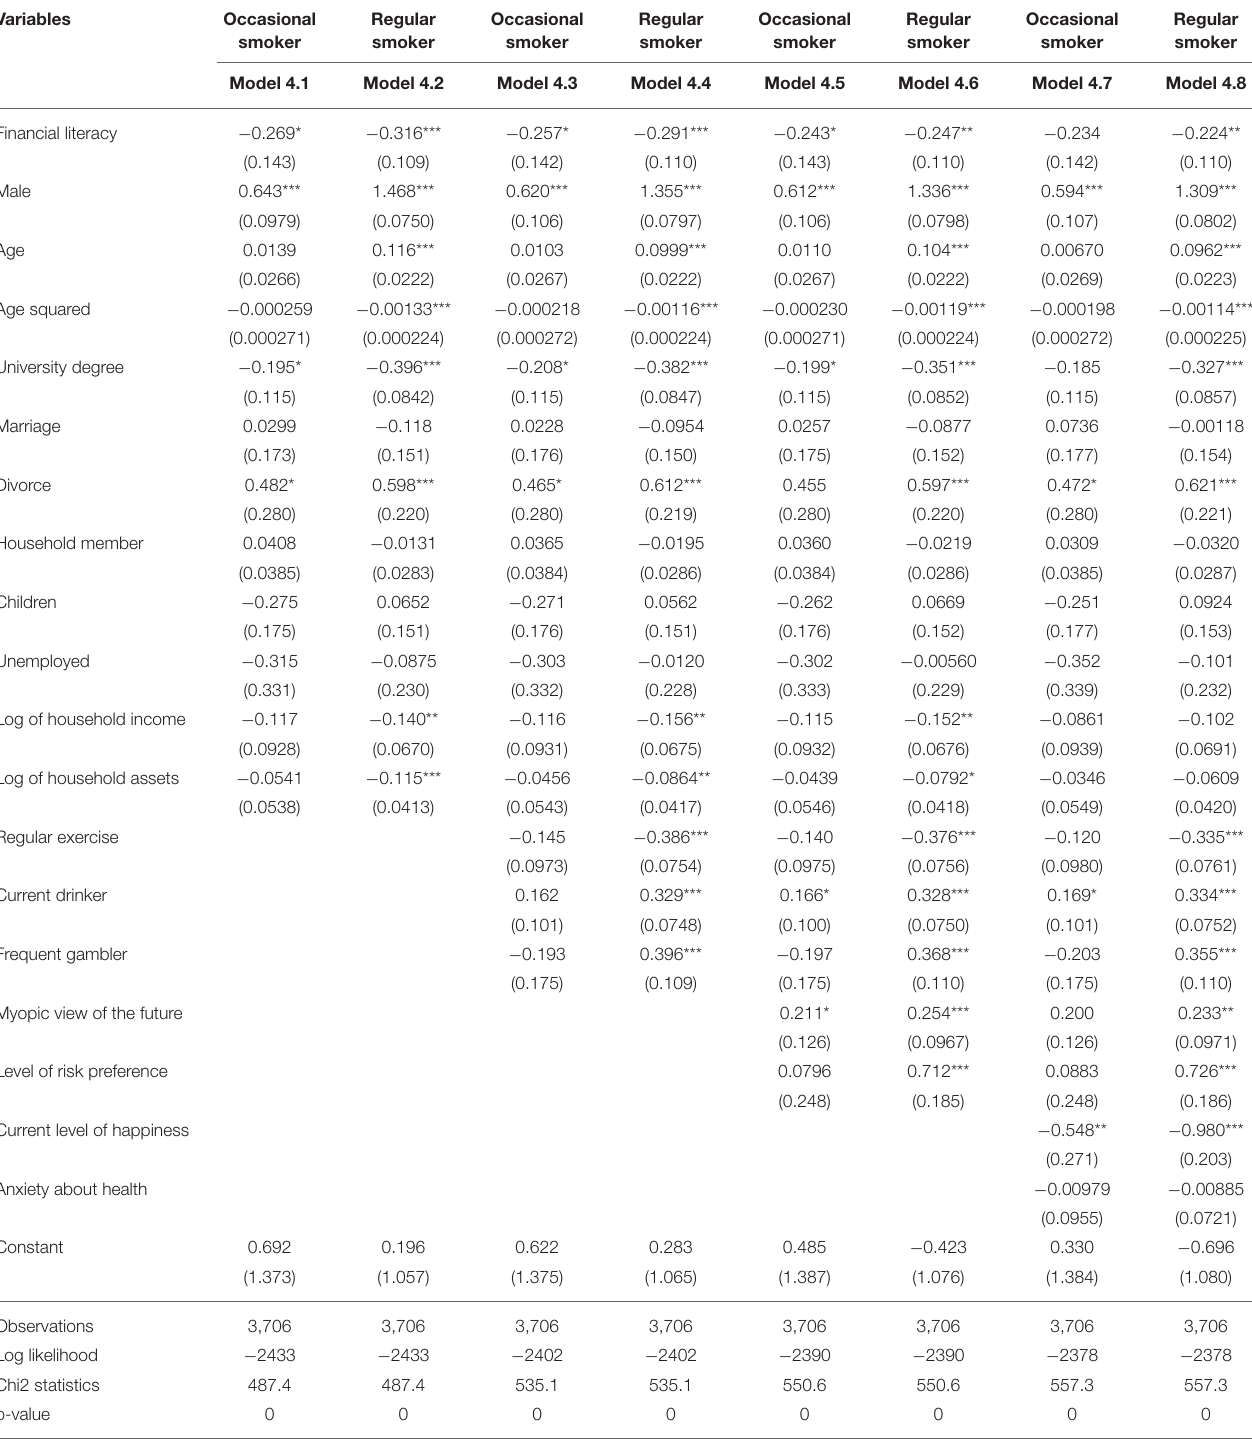
TABLE 9 | Multinomial probit model regression results, financial literacy as the main explanatory variable.